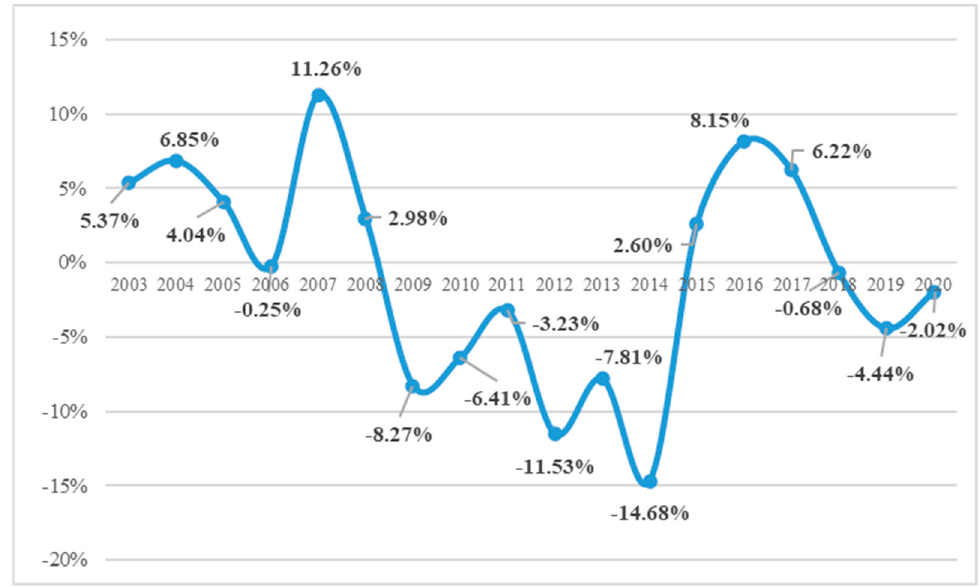
Figure 2. Ratio of the budget deficit/surplus to the annual budget revenues for 2003-2020 (in %) for the city of Katowice. Source: own elaboration.